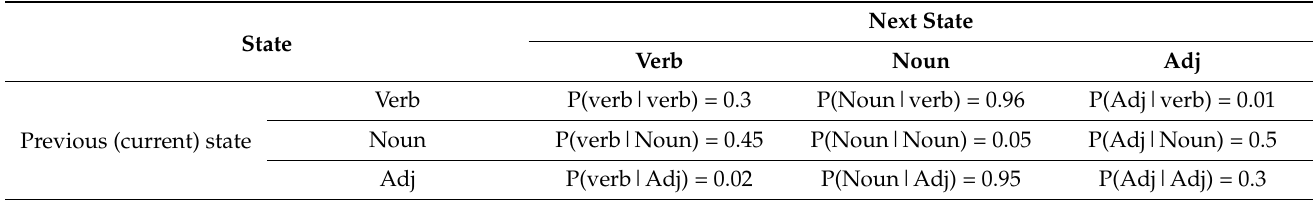
Figure 5. Markov Model with three states. Table 4. Transition Matrix (Probability of Transition).